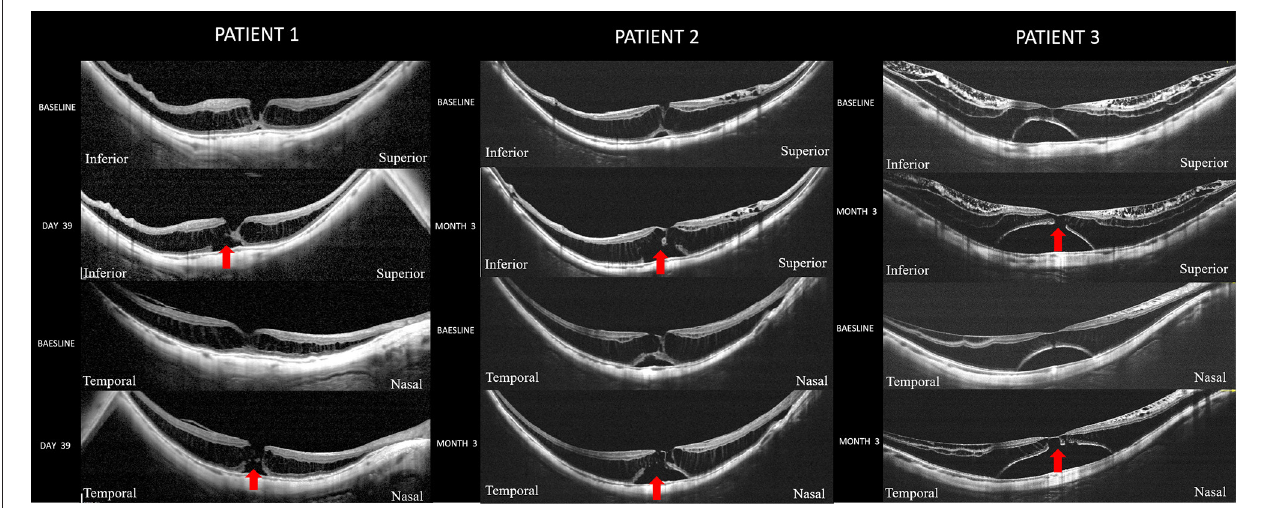
FIGURE 3 | Cases with foveal detachment experienced rapid progression. Patient 1 is a woman (55-year-old) with a spherical equivalent refractive error of − 23.0 D and an axial length of 32.4mm. Optical coherence tomography (OCT) scan across the fovea at the initial visit showed a retinoschisis spanning the entire macula with a lamellar MH. A slight foveal elevation can be seen. Thirty-nine days later, the extent of foveal detachment has increased and disruption of the outer retina (red arrow) has developed. The best corrected visual acuity (BCVA) declined from the logarithm of the minimum angle of resolution (logMAR) 0.70 to logMAR 1.0. Patient 2 is a woman (61-year-old) with an axial length of 31.74mm. At baseline, she had S4 retinoschisis involving the entire macula and a shallow foveal detachment. At the third month of the follow-up, the extent of foveal detachment increased with a disruption of the outer retina (red arrow) developed. The BCVA declined from logMAR 1.00 to logMAR 1.3. Patient 3 is a woman (50-year-old) with an axial length of 30.21mm. OCT scan at baseline showed an outer retinoschisis spanning the entire macula with commitment inner retinoschisis and internal limiting membrane detachment. A foveal detachment was observed. 3 months later, the foveal detachment has further enlarged and disruption of the outer retina (red arrow) was noted. The BCVA declined from logMAR 1.00 to logMAR